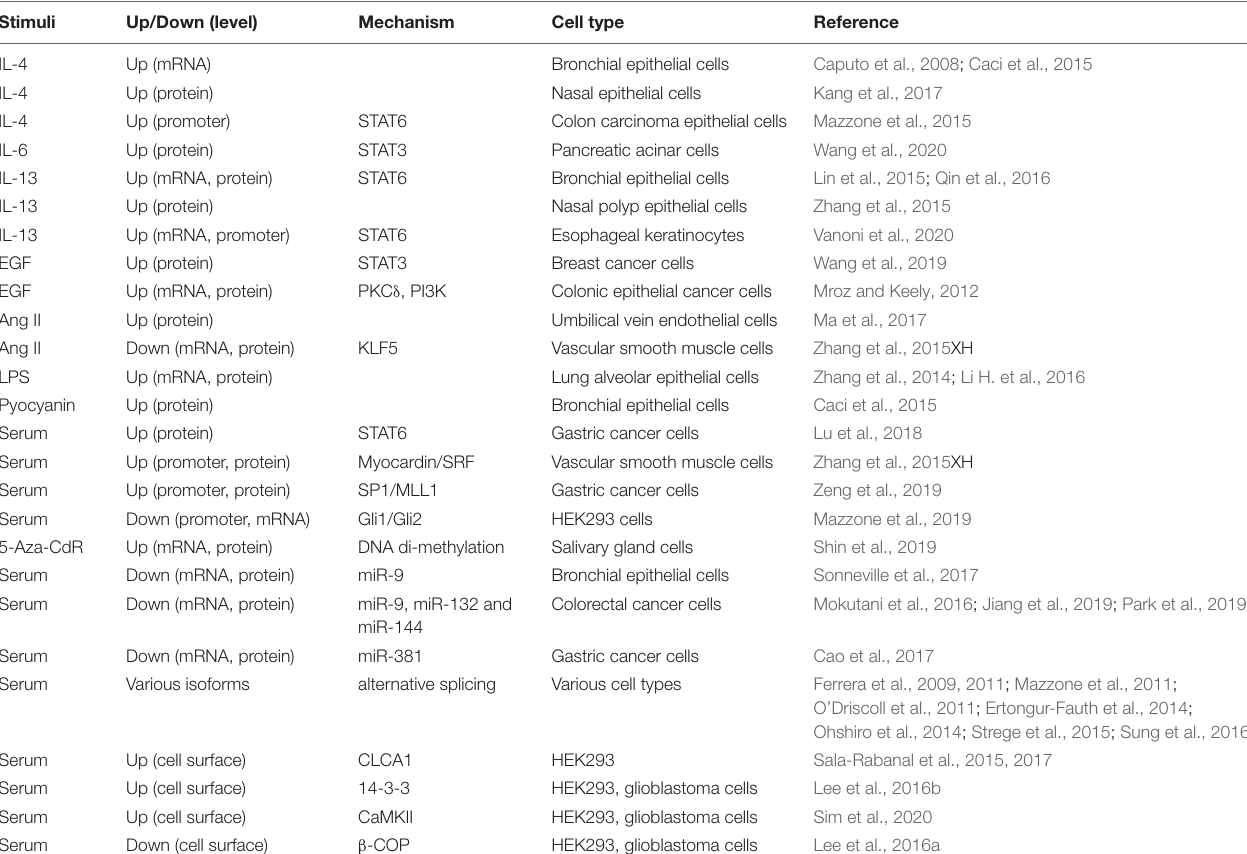
TABLE 1 | Regulation of ANO1 expression.